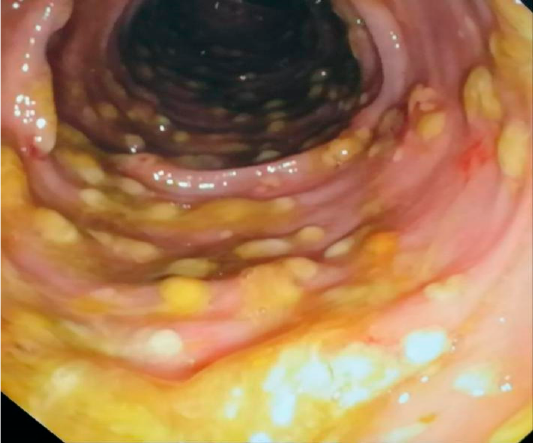
Figure 2. Endoscopic picture before FMT, personal collection.